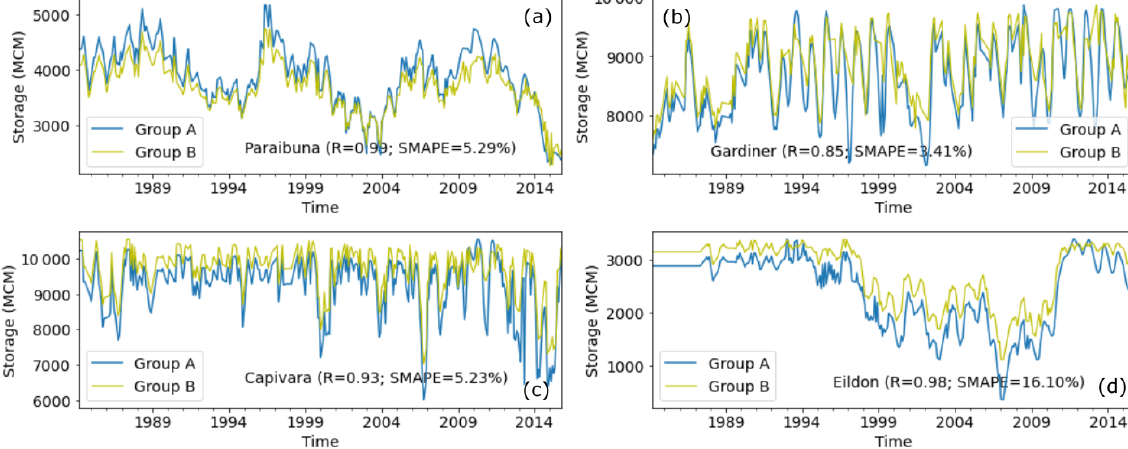
Figure 3. Validation of monthly reservoir storage time series reconstruction for Group B against results obtained using the method for Group